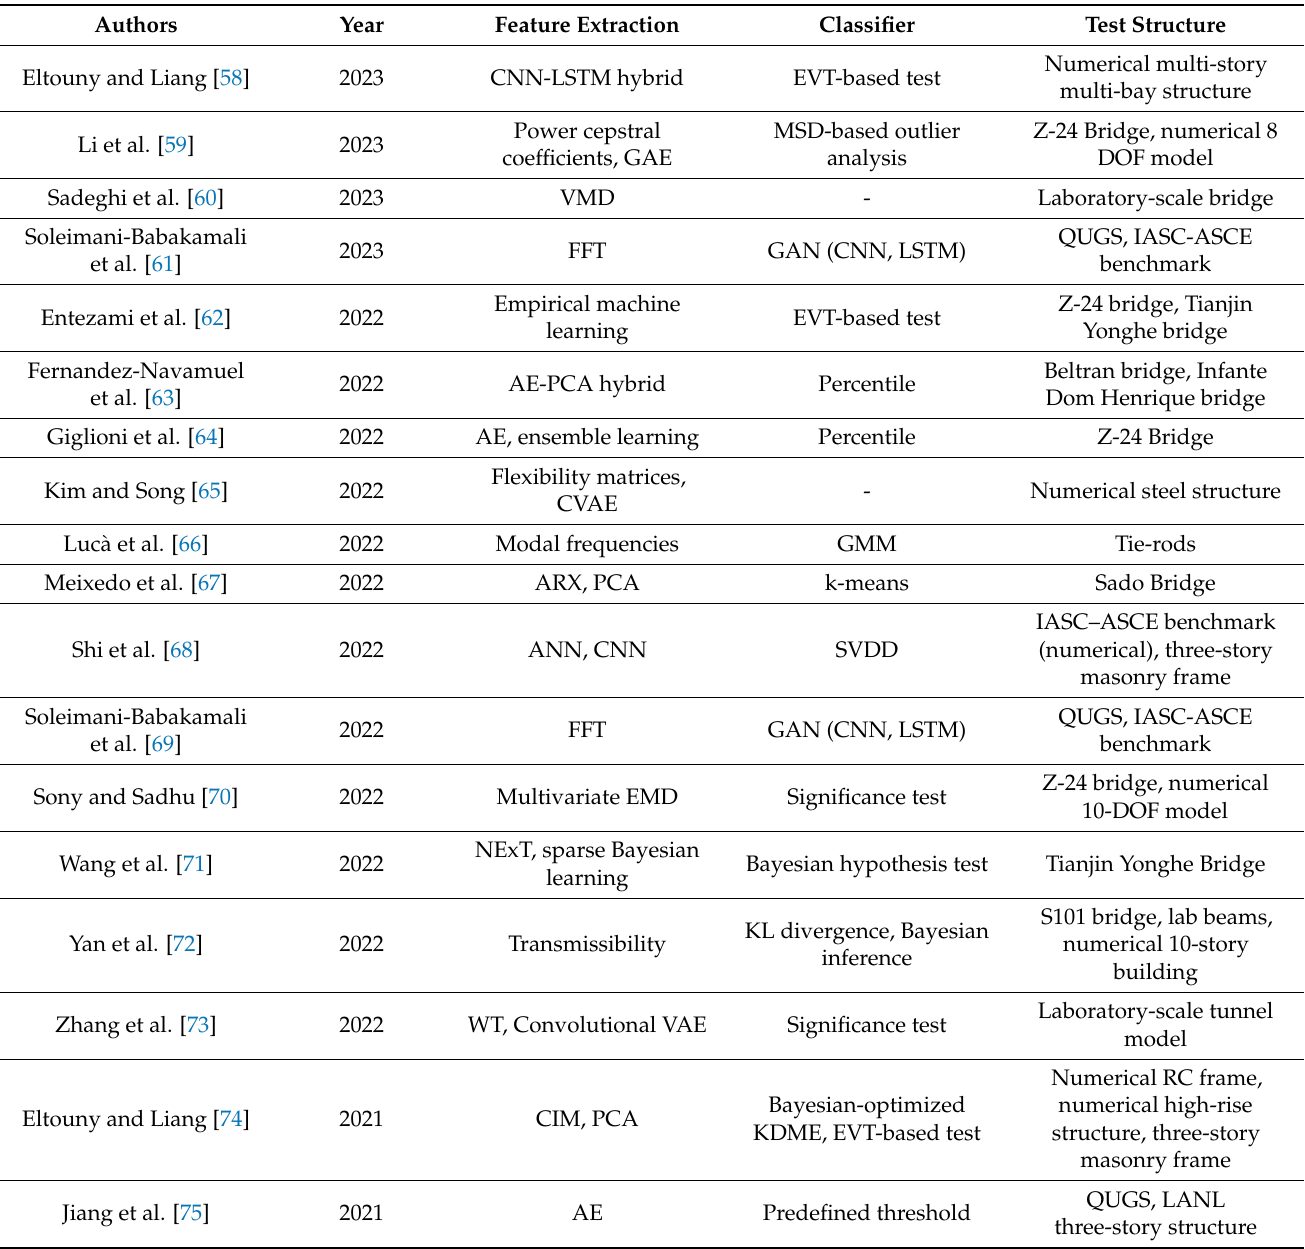
Table 1. Applications of unsupervised learning, vibration-based SHM (List of abbreviations is provided in Table